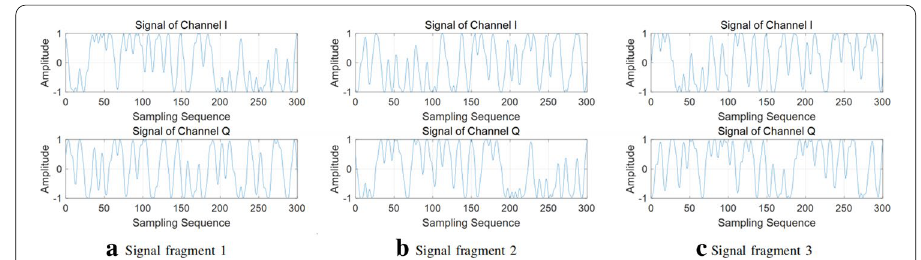
Fig. 6 The pre-processed signal waveform of device 1–3. Some fragments of the preprocessed signal waveform extracted from three devices are depicted in these figures. The abscissa represents the sampling point, and the ordinate represents the normalized signal amplitude corresponding to each sampling point. The time interval between adjacent sampling points is 10 − 7 s